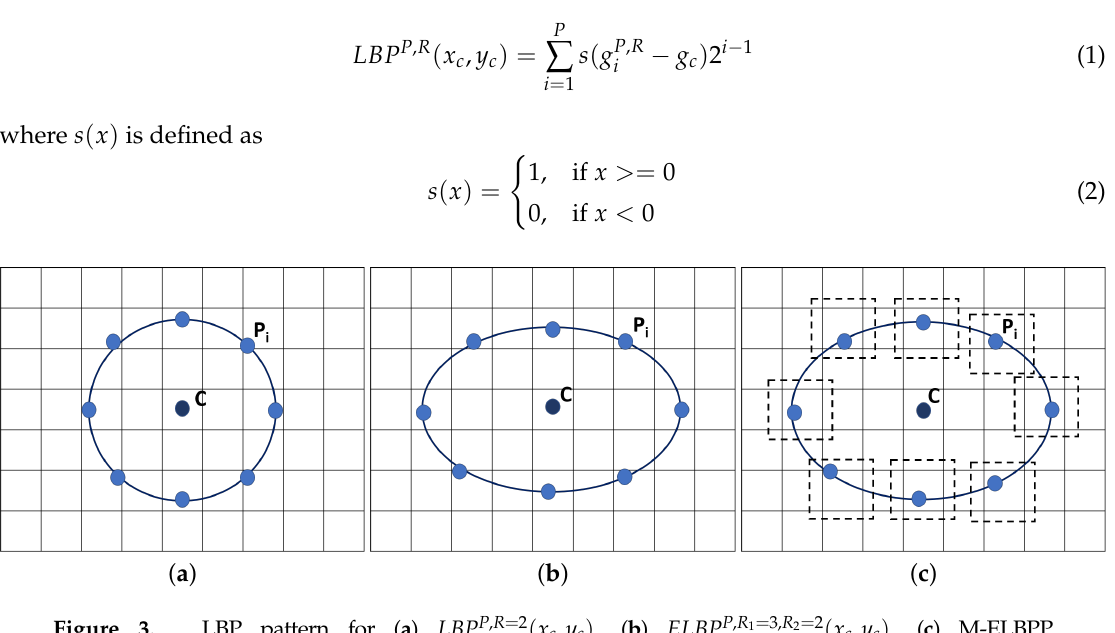
Figure 3. LBP pattern for ( a ) LBP P , R = 2 ( x c , y c ) , ( b ) ELBP P , R 1 = 3, R 2 = 2 ( x c , y c ) , ( c ) M-ELBPP, R 1 = 3, R 2 = 2 ( x c , y c ) where P =